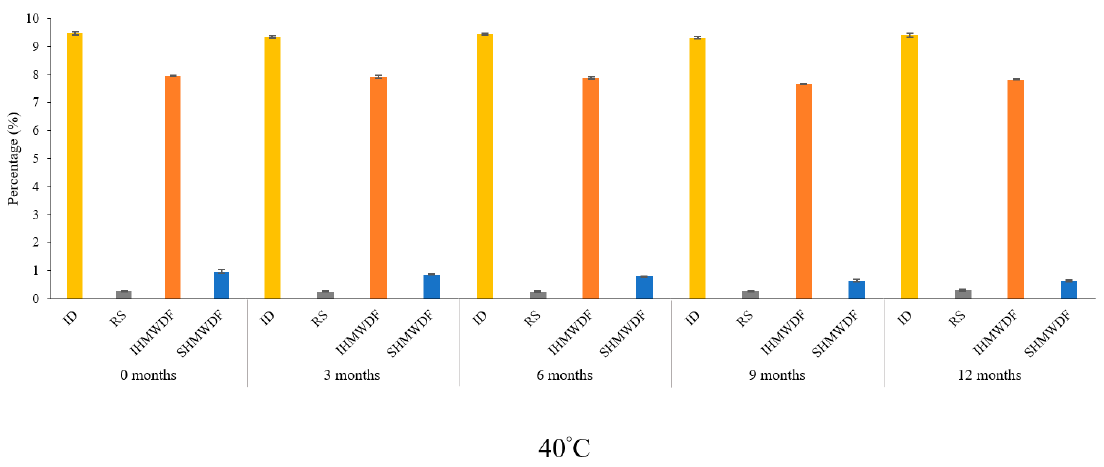
Figure 2. Fiber profile of wheat noodles fortified with isomaltodextrin during different storage periods (0, 3, 6, 9, and 12 months) at 40 ◦ C storage. ID, isomaltodextrin; RS, resistant starch; IHMWDF, insoluble high-molecular-weight dietary fiber; SHMWDF, soluble high-molecular-weight dietary fiber.